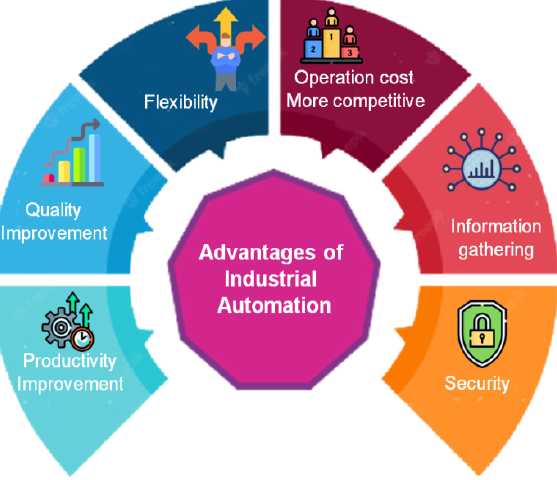
Figure 1. Advantages of industrial automation.